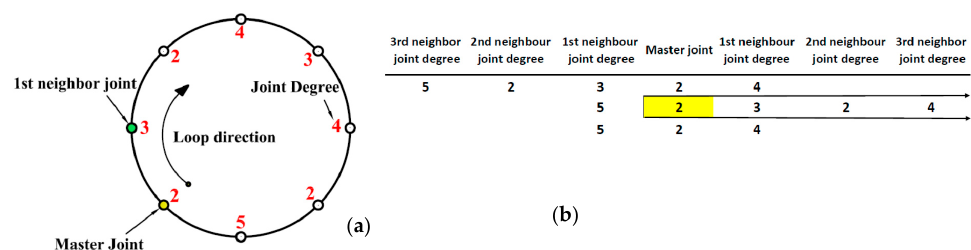
Figure 6. Generation of the ULA. ( a ) loop with multiple master joints. ( b ) Comparison between multiple master joint neighbors. 5.